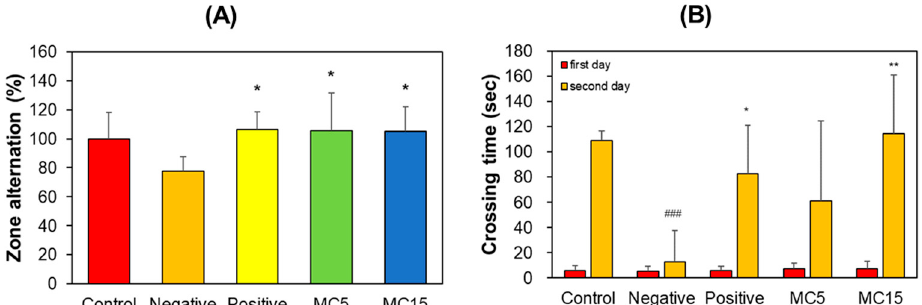
Figure 3. Effect of MC on short-term memory function. ( A ) Y-maze test; ( B ) PAT. Zone alternation and crossing time were measured by Y-maze and PAT, respectively. Data are presented as mean ± SEM. ### p < 0.001, compared to the control group; * p < 0.05 and ** p < 0.01, compared to the scopolamine-treated group (n = 8).